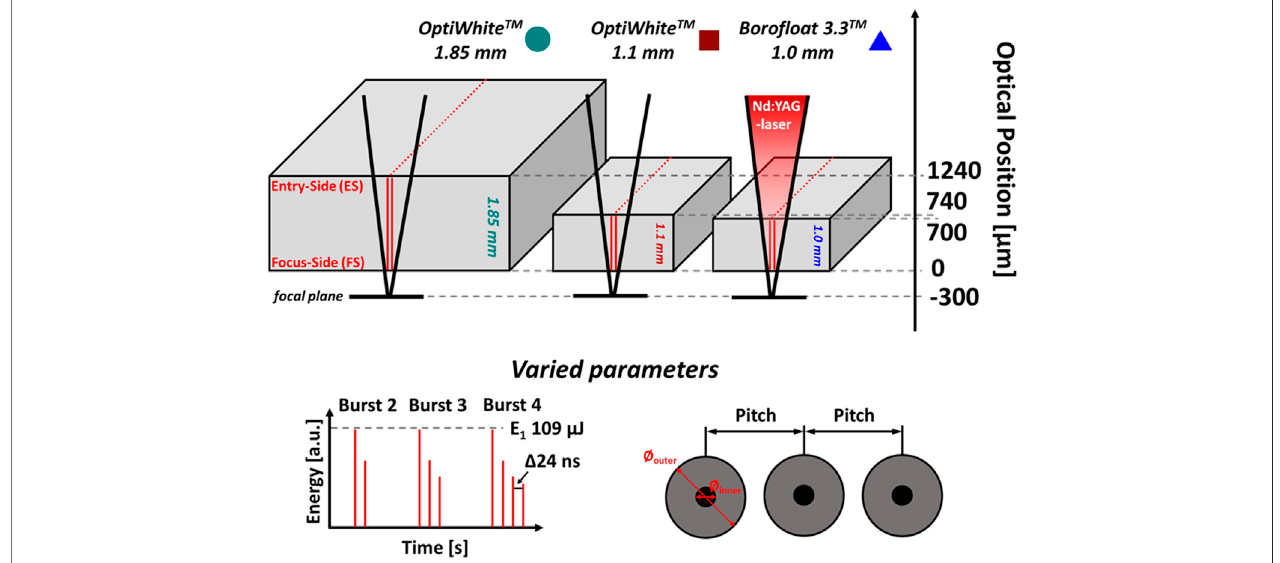
FIGURE 1 | Schematic drawing de fi ning the nomenclature and abbreviations. Turquoise dots a OptiWhite ™ 1.85 mm, Bordeaux red squares a OptiWhite ™ 1.1 mm, blue triangles a Boro fl oat 3.3 ™ 1.0 mm. Red lines and dots indicate laser fi lament orientation and location. The focal plane was set constant 300 µmbelowtheFocus-Side(FS).The “ opticalposition ” ontherightindicatesthelocationofthecorrespondingsurfaceconsideringtheindexofrefraction(graydashed lines are guide to the eye). At the bottom an explanation of the varied parameters is shown: variation of the pulses/ fi lament, i.e., Burst (left); fi lament to fi lament distance, i.e., Pitch (right). This fi gure is adapted from “ Figure 1 ” by [8] licensed under CC BY 4.0 [8] https://doi.org/10.1002/adem.202000471.